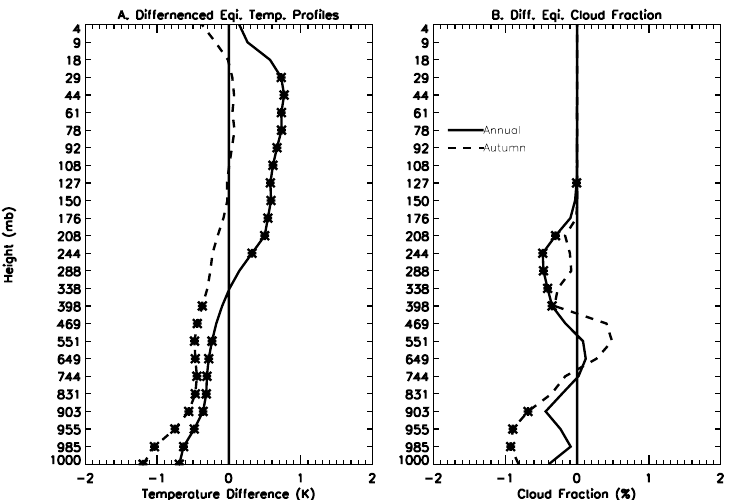
Fig. 11. Differenced (experiment less control) annual and autumn (September–November) mean temperature and cloud fractions for the equilibrated period of the CCSM bias sensitivity (last 20 of 60yr) for 70 ◦ N poleward. Asterisks indicate the difference between experiment and control is significant ( P <05) at the height